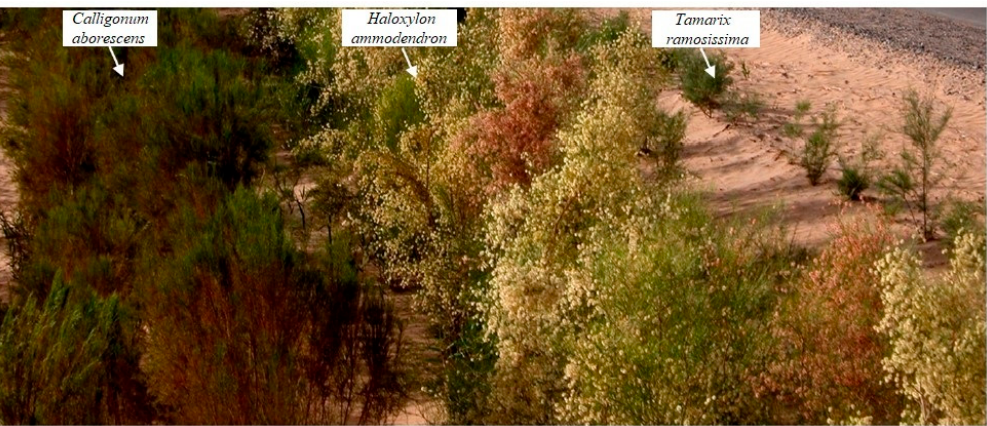
Figure 2. Three main species in Taklimakan Desert Highway shelterbelt (adapted from Zhang et al. [2]).